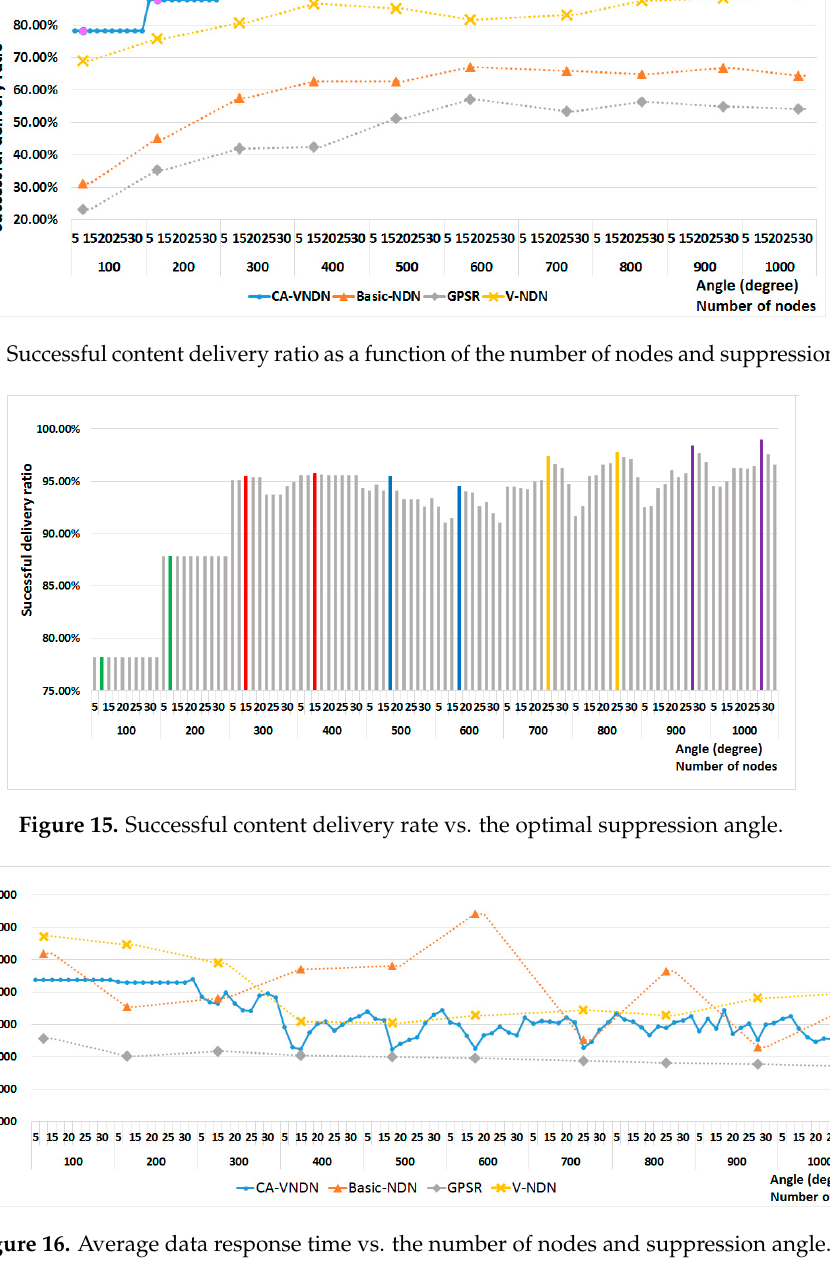
Figure 14. Successful content delivery ratio as a function of the number of nodes and suppression angle.